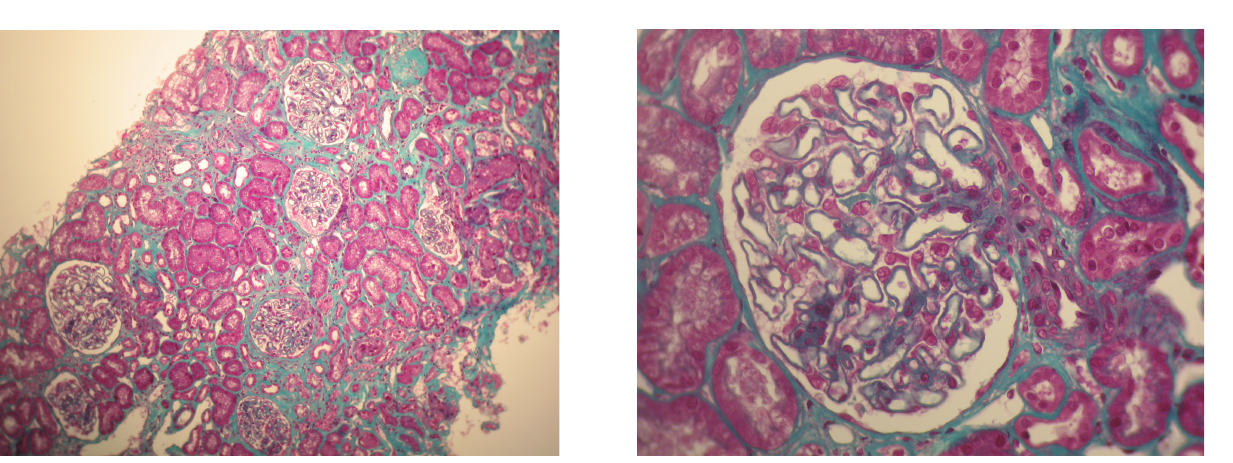
Figure 1: Tubulointerstial fibrosis with thickened glomerular basement membrane (Masson’s trichrome stain, x200).